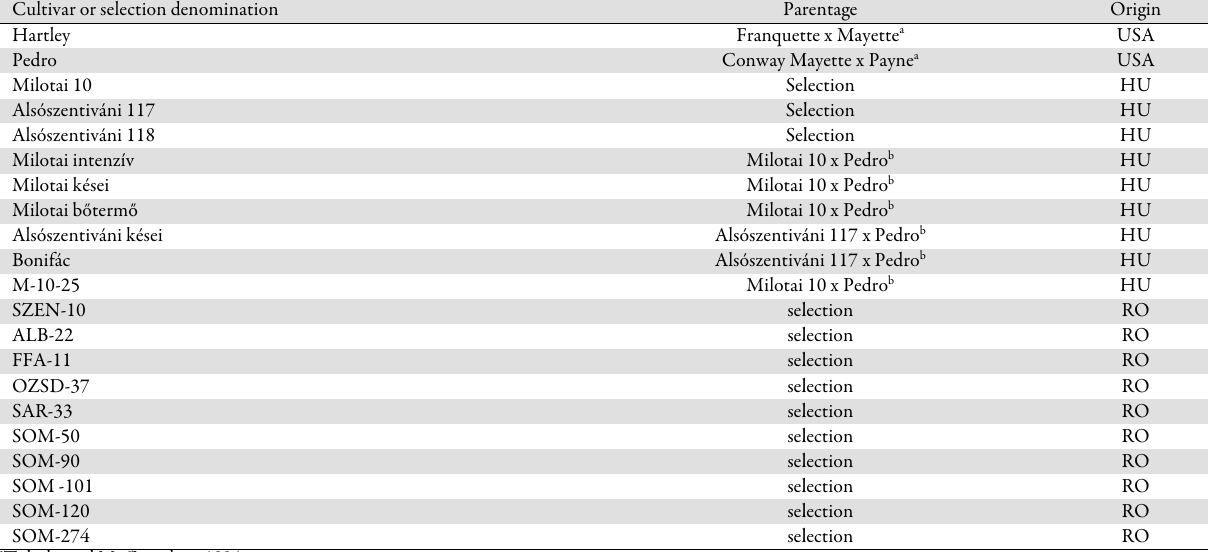
Table 1. Examined walnut cultivars and selections Cultivar or selection